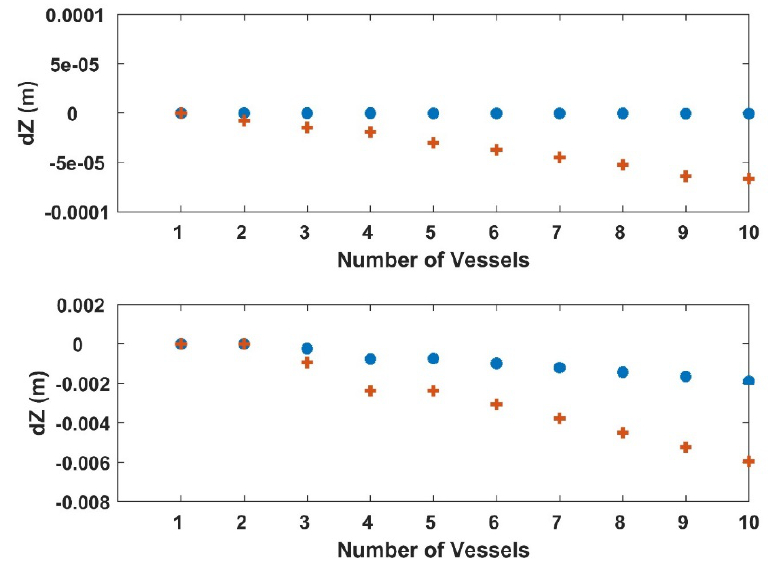
Figure 9. Wake-induced bed elevation change as a function of the number of vessels entering the study area (top panel: station b of transect 1; bottom panel: near station a of transect 2. The vessel sailing speed is 15 knots (circles for small vessels and plus signs for large